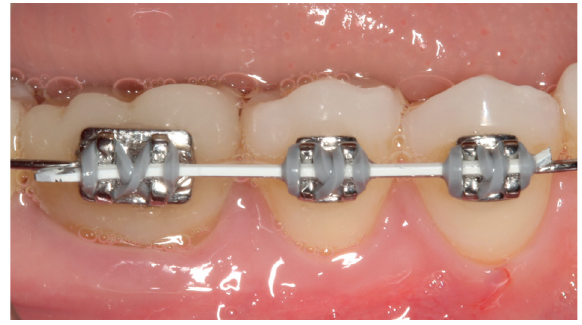
Figure 2. Esthetic coated wire in the oral environment. Wires were placed juxtaposed to the pre-existing metal archwire and tied with gray elastic ligatures as figure eight elastic